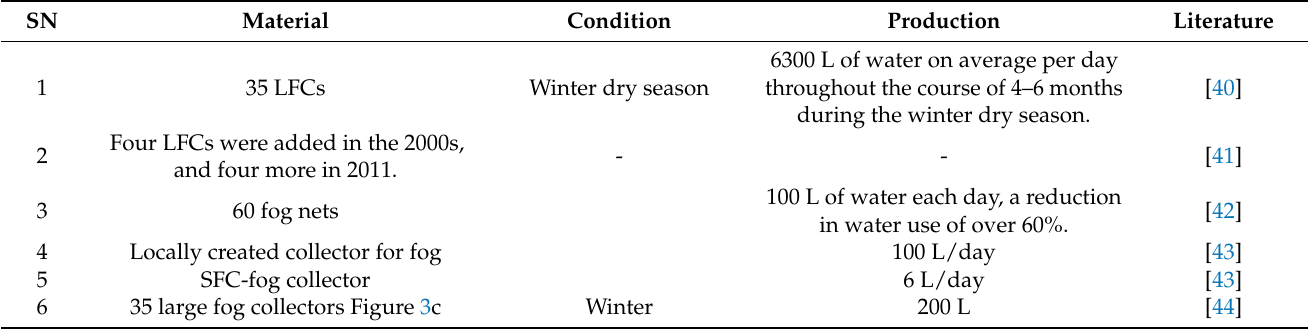
Table 2. Comparison of different types of Fog water